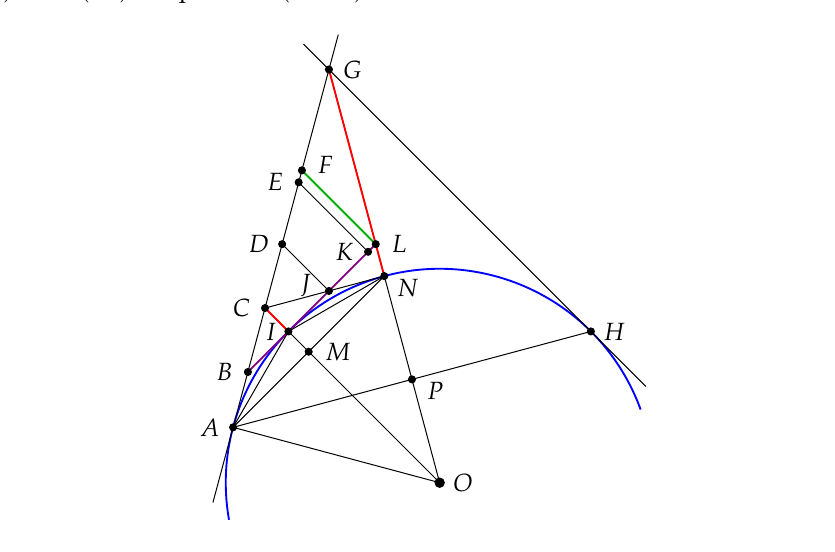
Figure 2. The sequence of heights ( h n ( m )) is a null